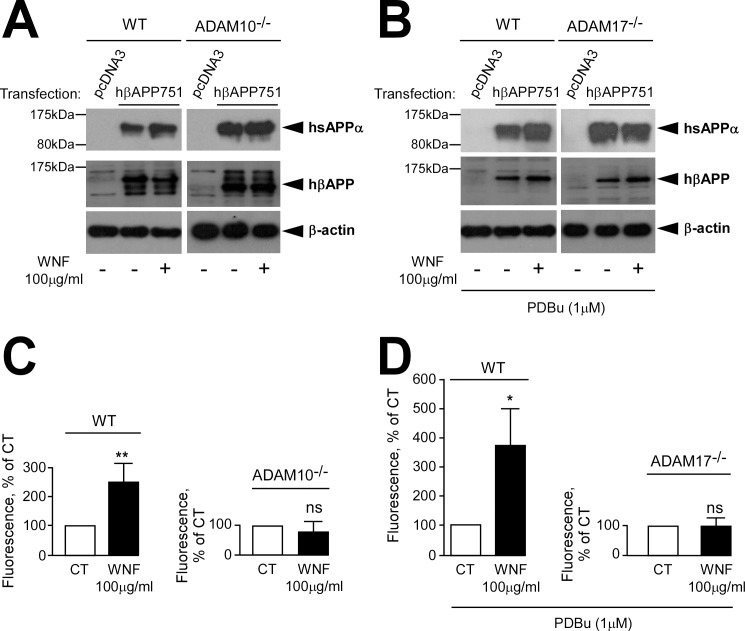
ADAM10 and ADAM17 knockouts respectively abolish the constitutive and PDBu-stimulated WNF-induced sAPPα secretions and JMV2770 hydrolysis in mouse embryonic fibroblasts.(A, B) Wild-type (WT) (A, B, left panels), ADAM10-/- (A, right panel) or ADAM17-/- (B, right panel) MEFs were transfected for 24 hours with empty or human βAPP751-encoding pcDNA3. Eight hours post transfection, cells were incubated without (-) or with (+) WNF (100μg/ml) for 16 hours (in 1ml of DMEM/1% FBS). Cells in (B) were subsequently treated with PDBu (1μM) for 2 hours and all cells were allowed to secrete for 3 hours (in 1ml serum-free DMEM). Proteins in media were precipitated with 15% TCA and cells were collected and homogenized in lysis buffer. sAPPα, βAPP and β-actin were detected by western blot. (C, D) Wild-type (WT) (C, D, left panels), ADAM10-/- (C, right panel) or ADAM17-/- (D, right panel) MEFs were incubated without (CT) or with WNF (100μg/ml) for 16 hours (in 1ml of DMEM/1% FBS). Cells in (D) were subsequently treated with PDBu (1μM) for 2 hours. JMV2770 (10μM) was then added (in 1.5 ml of PBS) in the absence or in the presence of o-phenanthroline (100μM) and fluorescence was recorded. Values in black bars are expressed as the percent of control (no treatment, white bars) calculated at 30 min and are the means ± SE of 6 to 10 independent experiments. *p<0.03; **p<0.02; ns, non-statistically different.